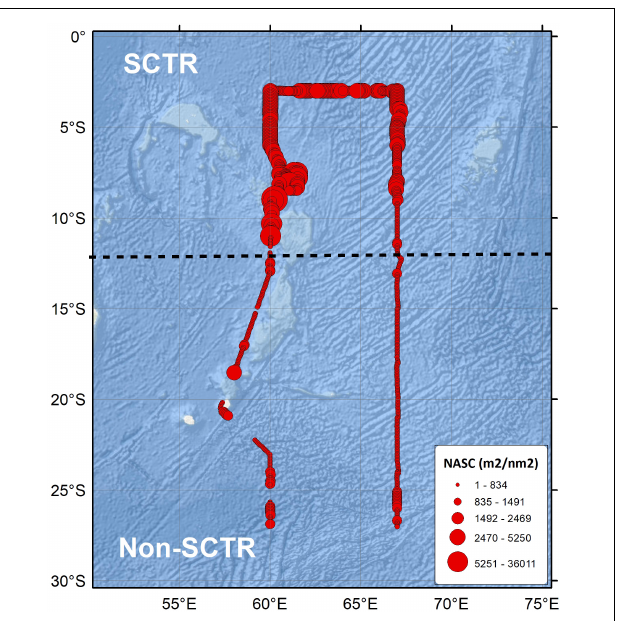
FIGURE 3 | The thematic map of acoustic scatterers. The black dotted line is a reference line, which is 12 ◦ S, to define SCTR and non-SCTR regions.